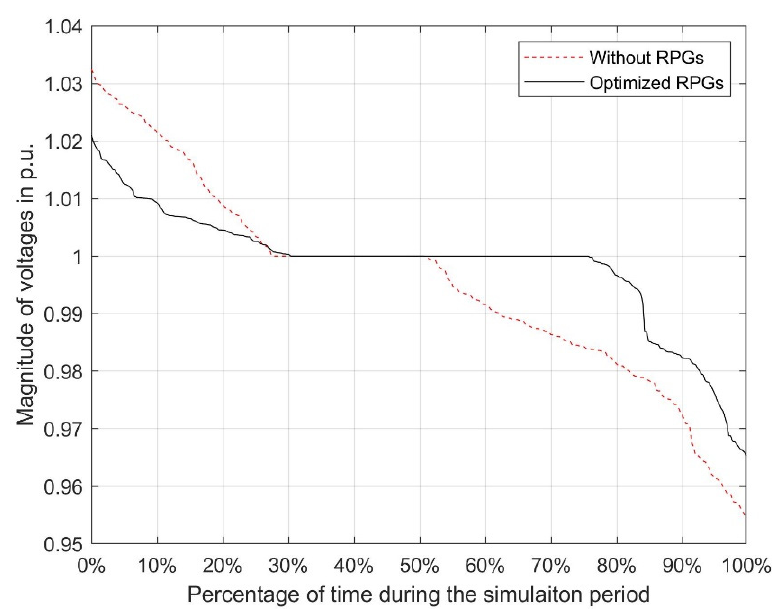
Figure 17. Voltage profile improvement in the IEEE 14-bus system.